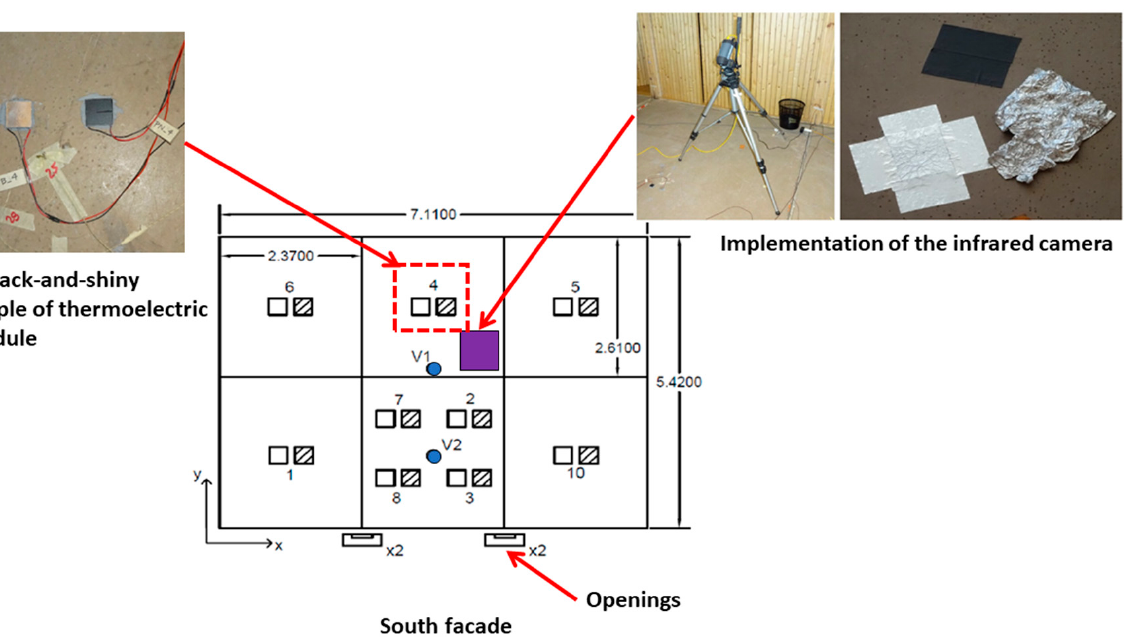
Table 2. Summary of the instruments’ characteristics implemented for local measurements.